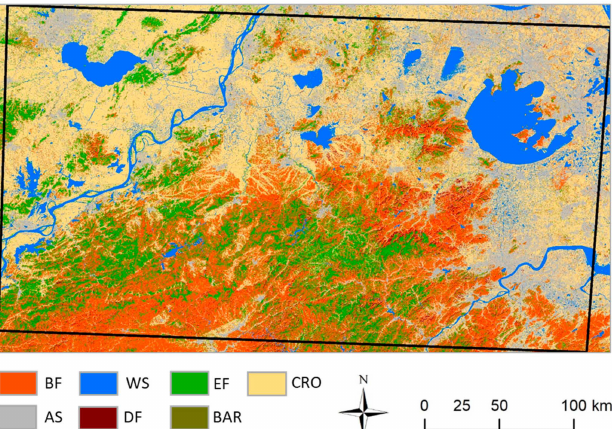
Figure 6. Spatial distribution of classification result. Abbreviation has the same meaning as in Figure 5.